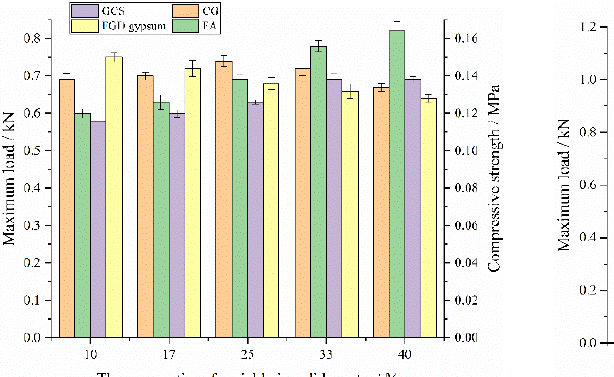
Figure 6. Bleeding-rate test results.